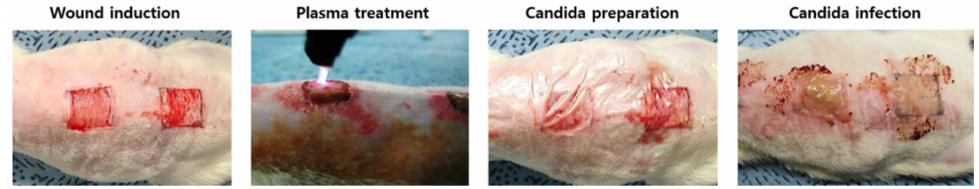
Figure 3. Representative gross photographs of the